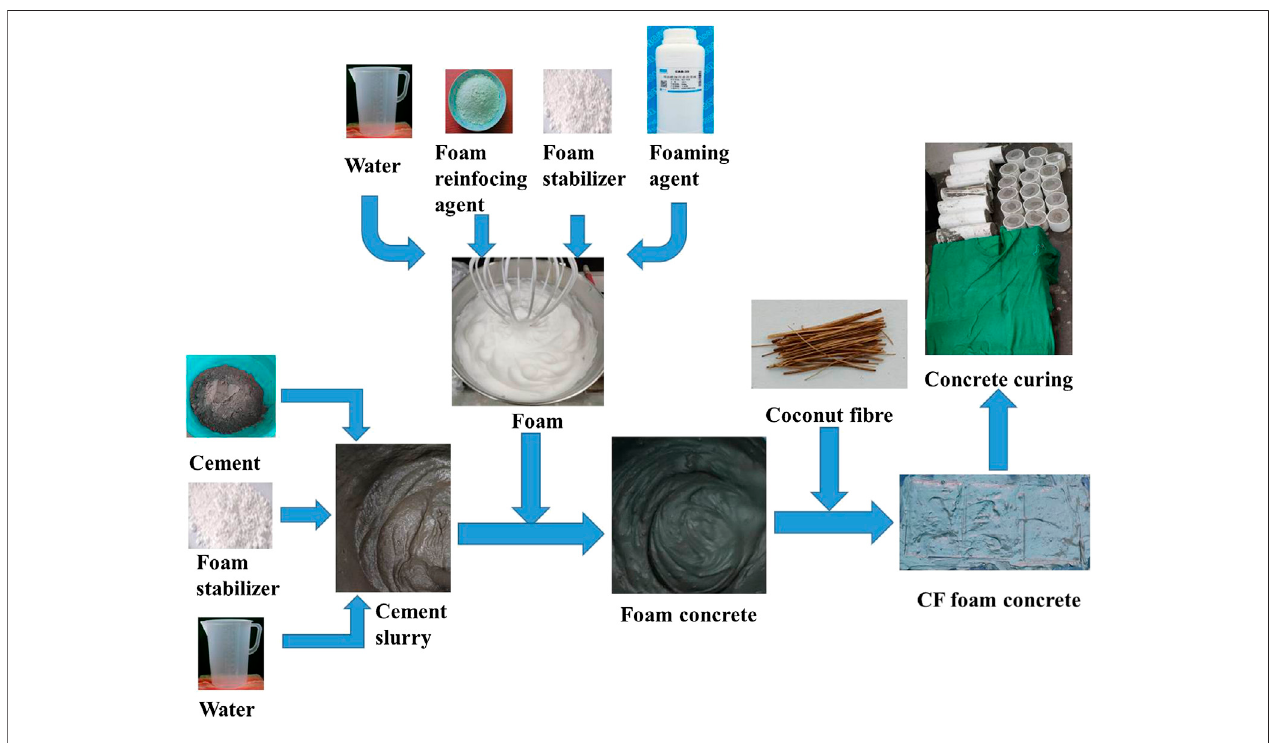
FIGURE 2 | Production process of CF-foam